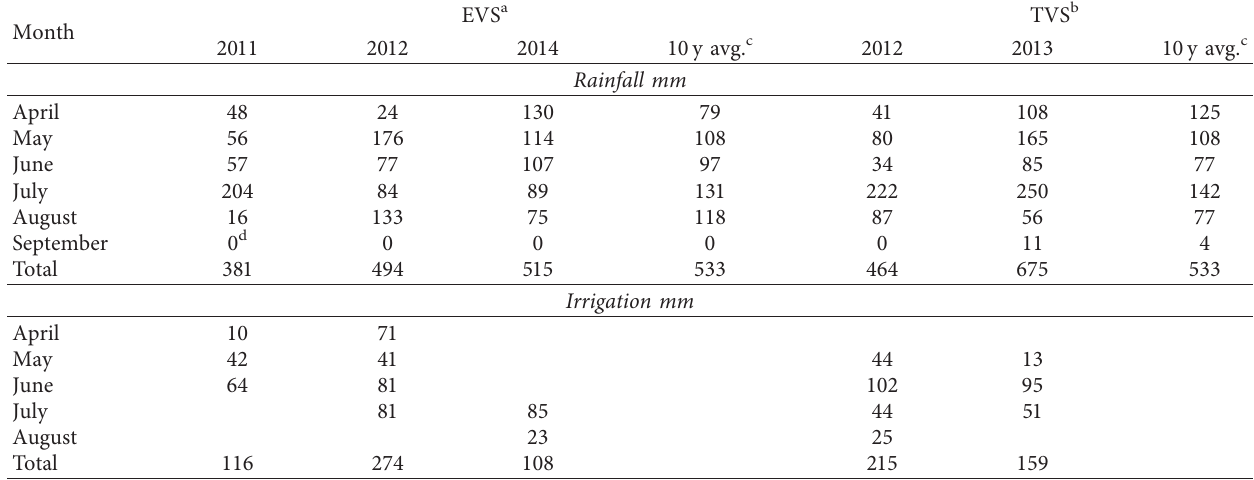
Table 3: Distribution by month and totals for rainfall and irrigation at five site-years during the 2011 to 2014 growing seasons across northern and central Alabama.